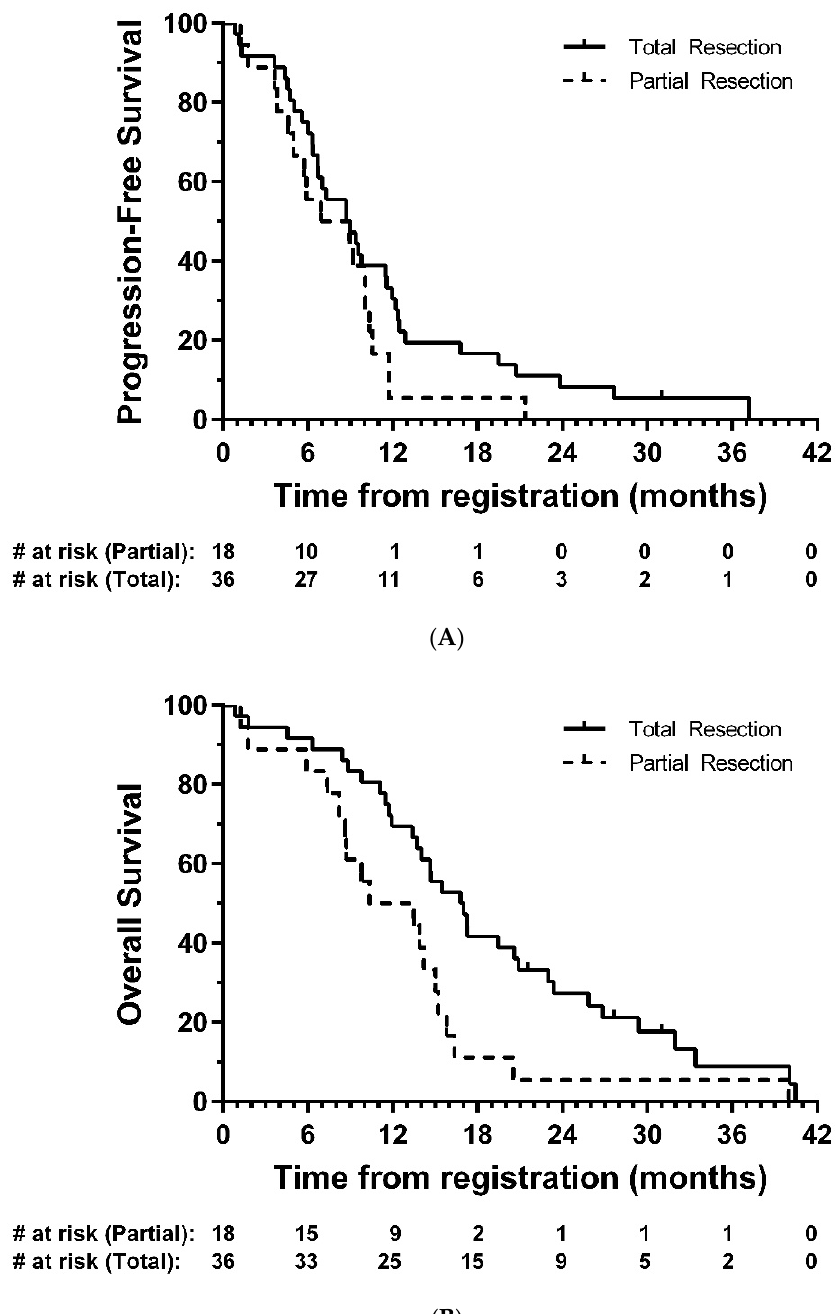
Figure 3. Kaplan–Meier plots of ( A ) progression-free and ( B ) overall survival—eligible patients, by resection group. # =